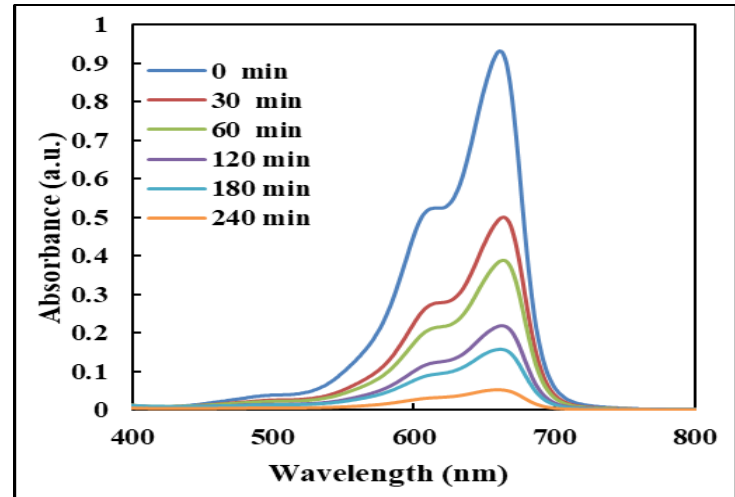
Figure 7: UV-Vis. absorption spectra of MB(5ppm) catalysis by 4g/40 ml for ZnO/epoxy nanocomposite